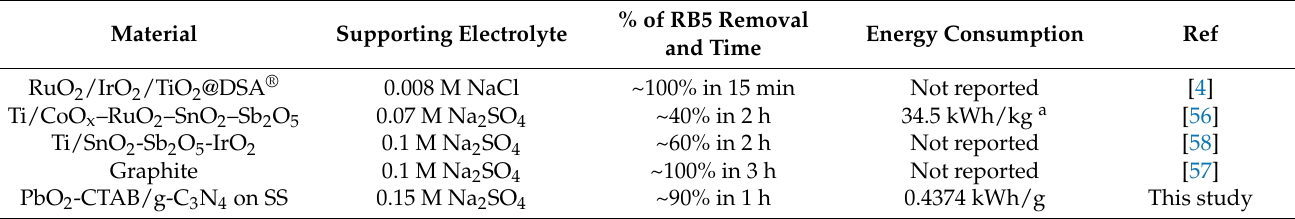
Table 2. The RB5 degradation efficiency comparison with the literature